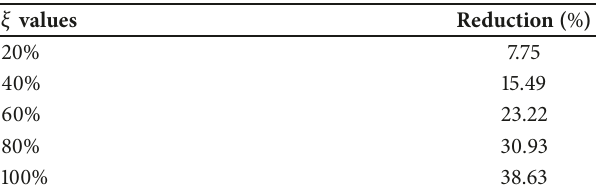
Table 3: Percentage reductions in the number of new cases due to variation in parameter 𝜉 – the probability of an effective surveillance in blood transfusion.